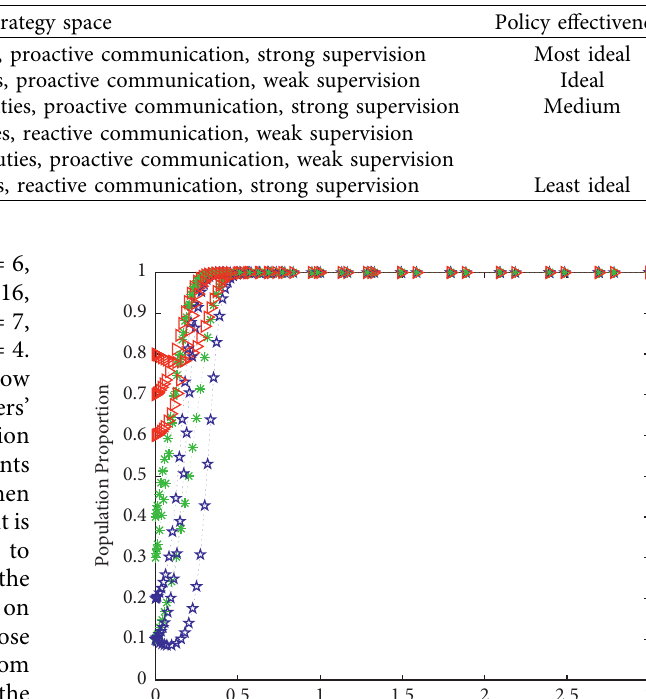
Table 4: Strategy space of the tripartite game model.